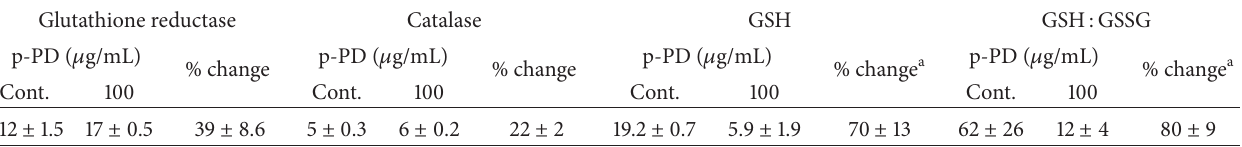
Table 4: Change in the biochemical parameters of oxidative stress induced by 100 𝜇 g/mL of p-PD for 24 hours on A375 cells. Glutathione reductase Catalase GSH GSH : GSSG p-PD ( 𝜇 g/mL) p-PD ( 𝜇 g/mL) p-PD ( 𝜇 g/mL) p-PD ( 𝜇 g/mL) % change % change % change a % change a Cont. 100 Cont. 100 Cont. 100 Cont. 100 12 ± 1.5 17 ± 0.5 39 ± 8.6 5 ± 0.3 6 ± 0.2 22 ± 2 19.2 ± 0.7 5.9 ± 1.9 70 ± 13 62 ± 26 12 ± 4 80 ± 9 a